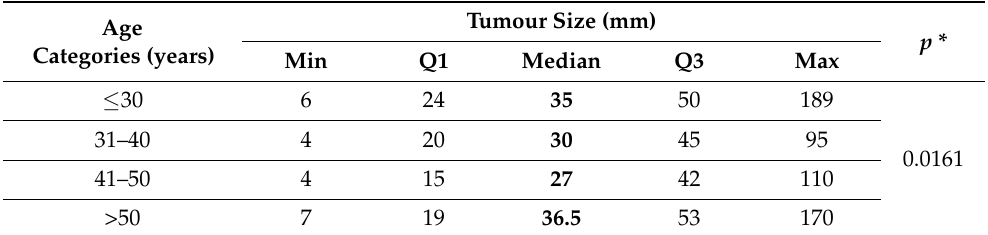
Table 15. Distribution of tumour sizes stratified by age categories in patients with germ-cell tumours, only (SE +